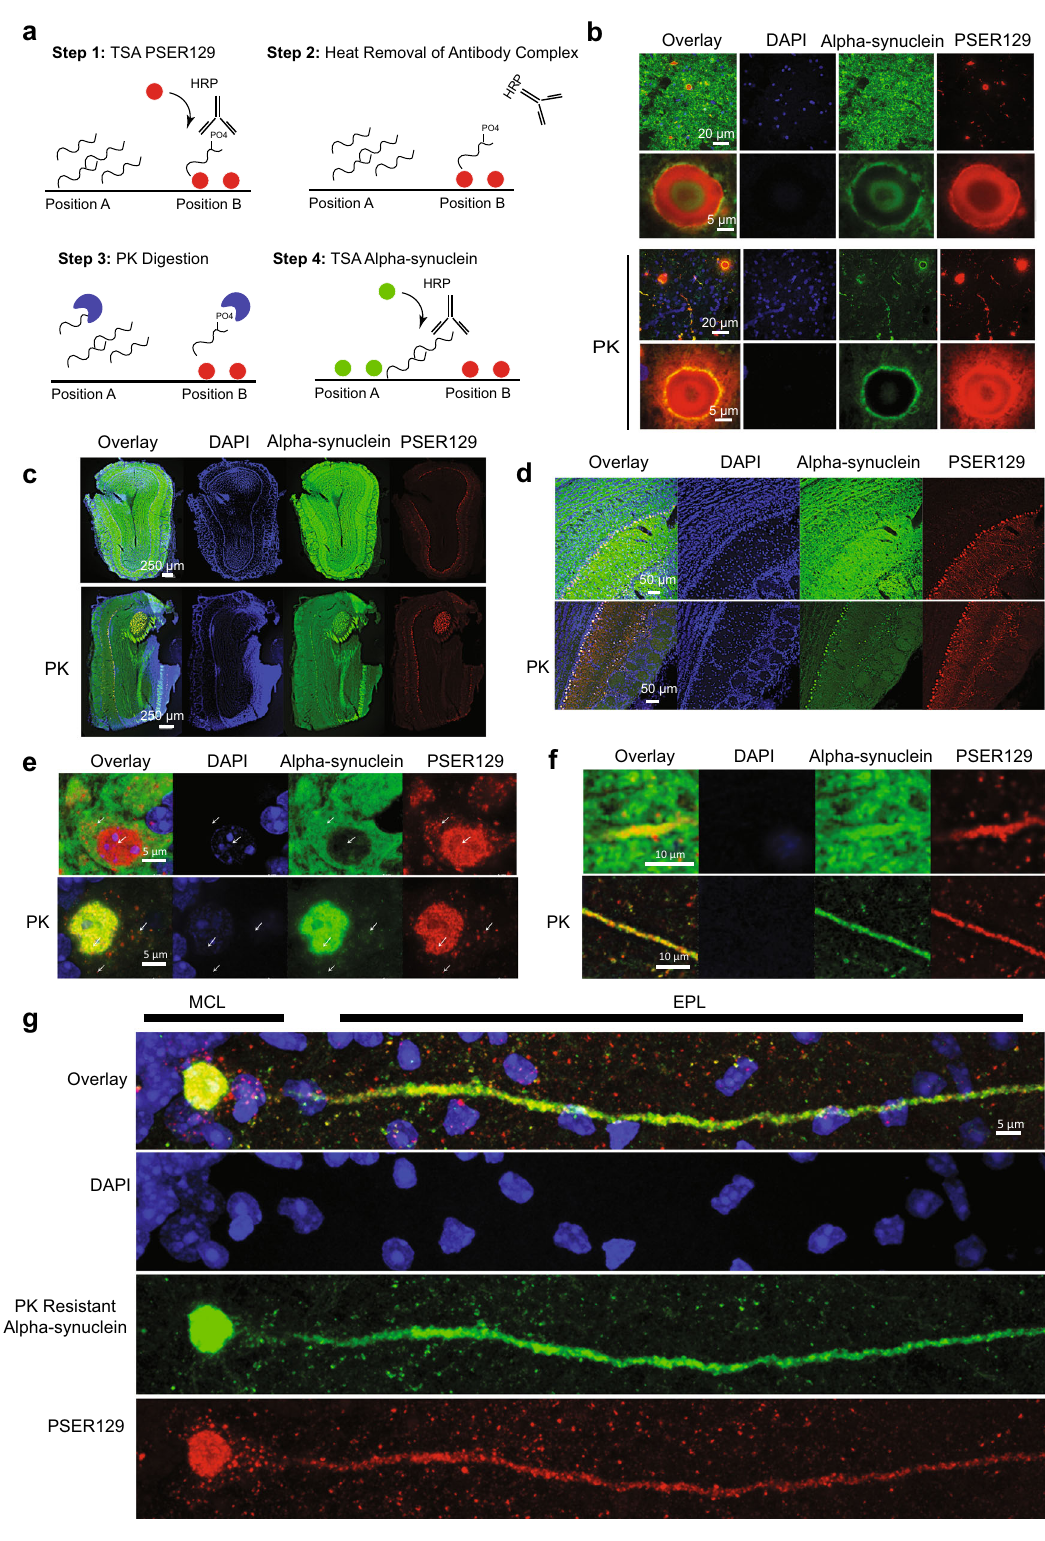
processes are a high-probability site for disease initiation. Aggravating factors like infection (viral or bacterial) via nasal cavity 1 might promote alpha-synuclein accumulation 51 and preferentially initiate the pathological process in susceptible mitral